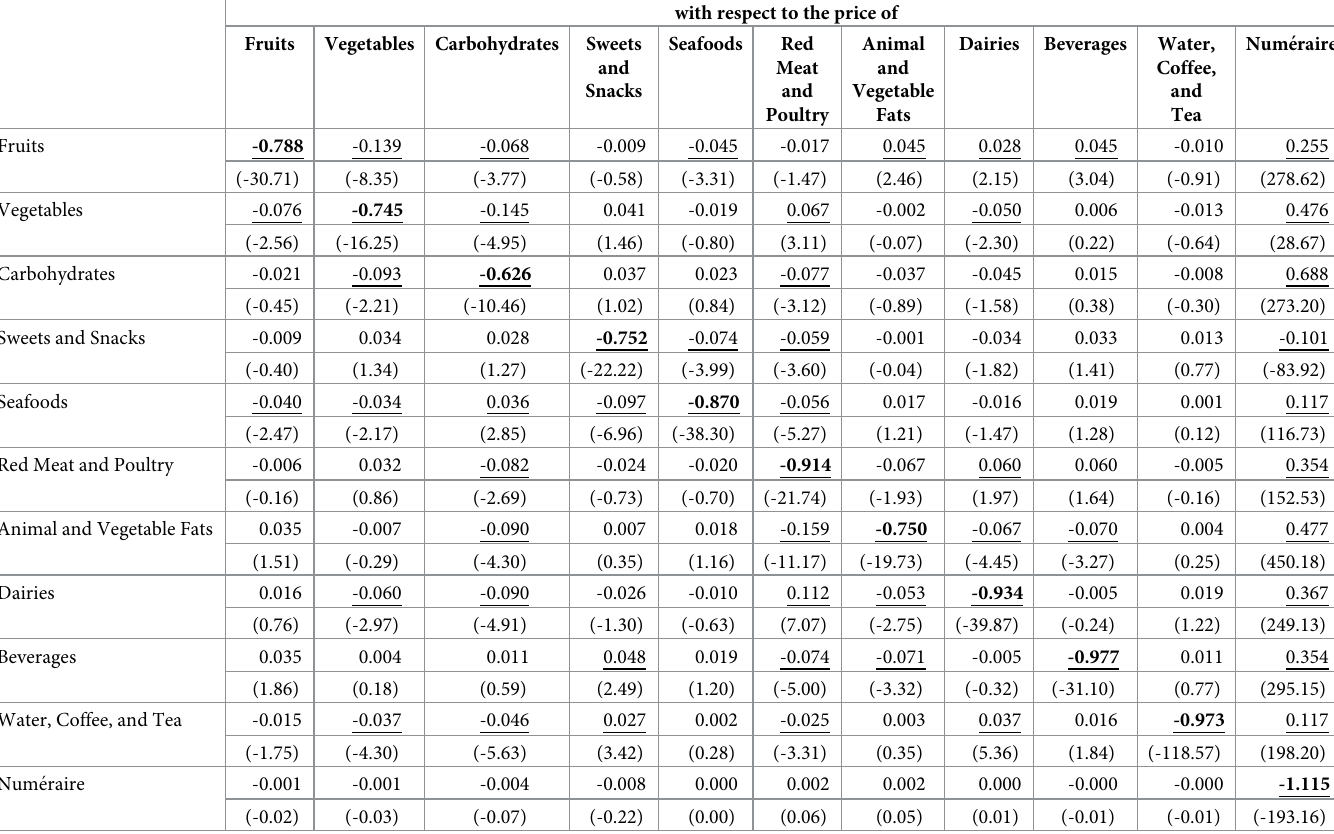
Table 3. Mean Marshallian price elasticities, full